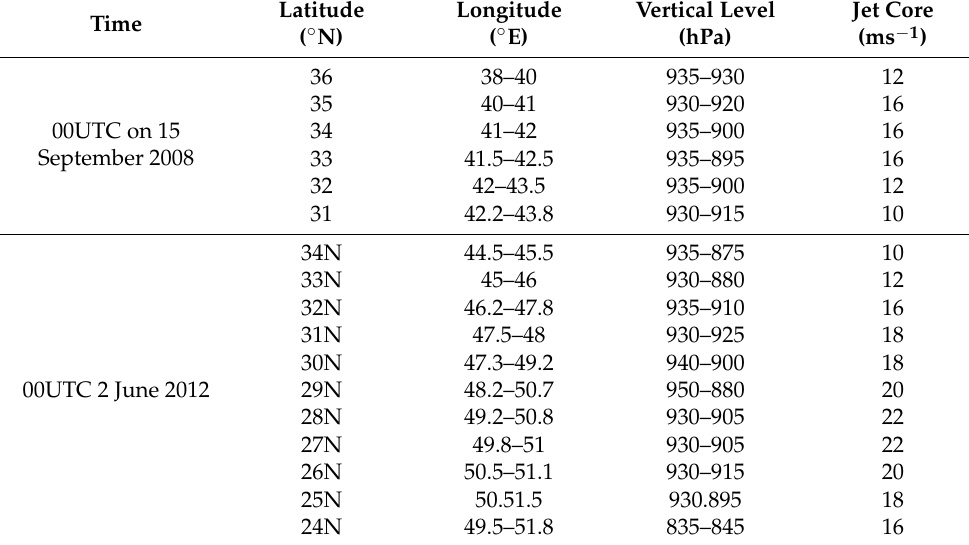
Table 3. The position, vertical expansion, and the jet core at the times indicated.